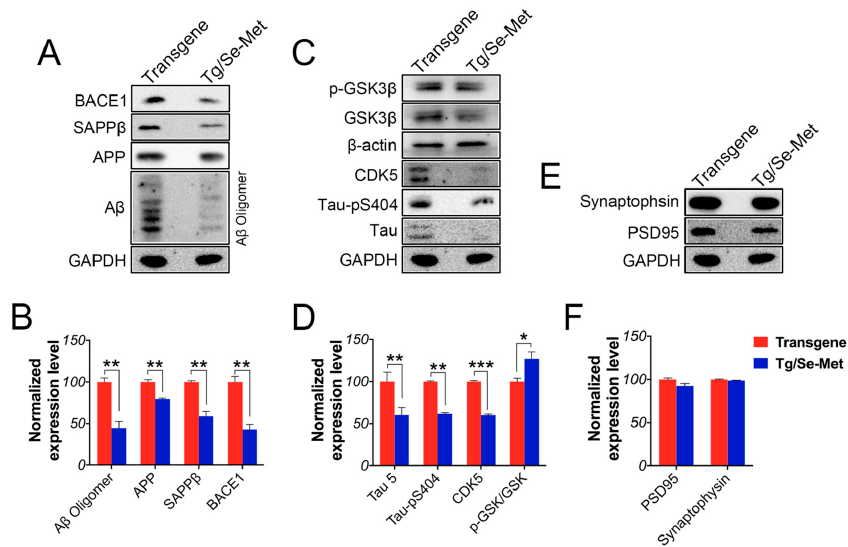
Figure 6. Se-Met treatment improved AD related pathology in the primary neurons of the OB. ( A – F ) Western blot analysis of AD-related pathological proteins in the primary neurons of the OB indicated that Se-Met could significantly decrease the levels of A β oligomers, APP, SAPP β , BACE1 and total tau protein, inhibited hyperphosphorylation of tau at Ser404, and reduce the level of CDK5 and the activity of GSK3 β , without increasing the expression levels of synaptic proteins. Quantitative results were normalized against the levels of β -actin or GAPDH. Values are expressed as percentages in comparison with the control (set to 100%) and presented as the group mean ± SEM ( n = 3). * p < 0.05, ** p < 0.01, *** p < 0.001 vs. the transgene group.